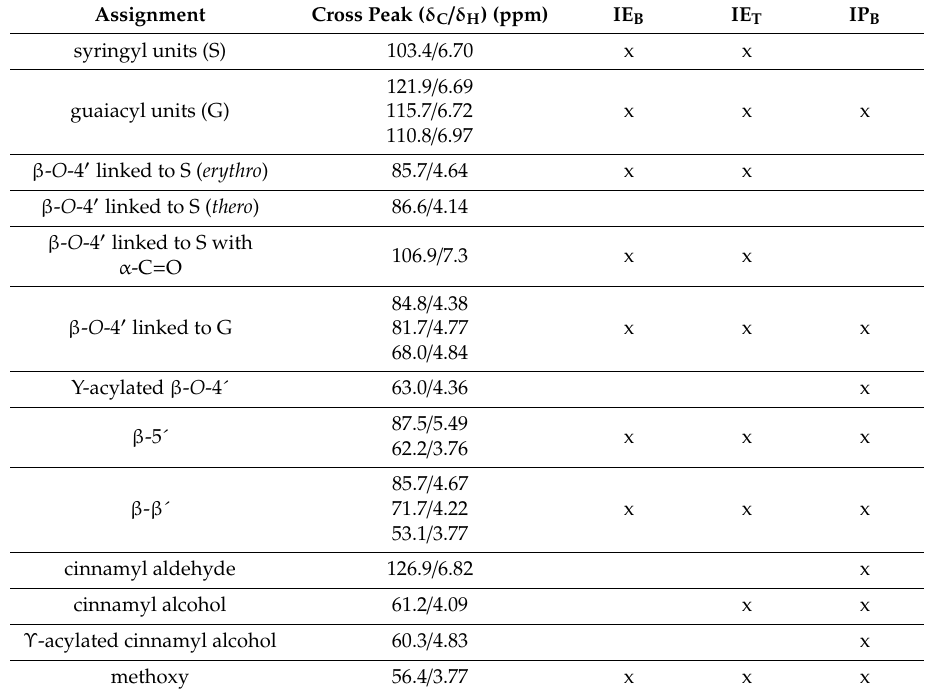
Table 3. Structural units identified in qualitative 1 H– 13 C-HSQC analyses of E. nitens lignin recovered after delignification treatment for both ionic liquids; for comparison, data for the Ionosolv lignin from Pinus pinaster wood ( IP B ) [20] are listed. Chemical shifts of cross peaks used for identification are indicated.